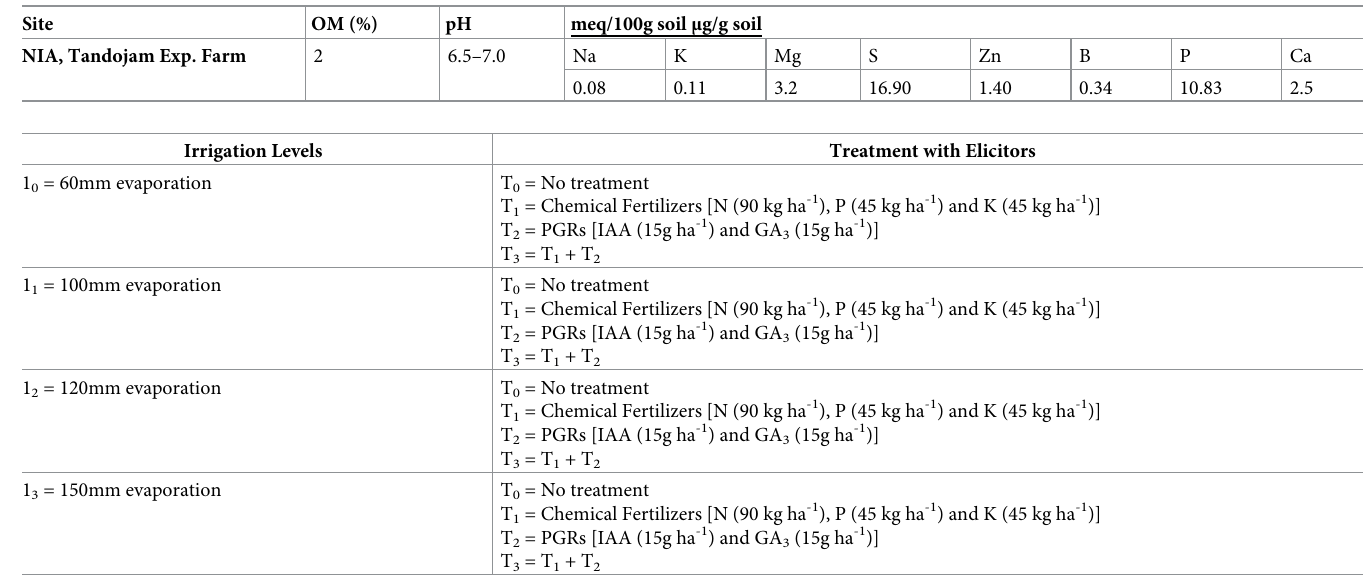
Table 2. Soil properties of experimental